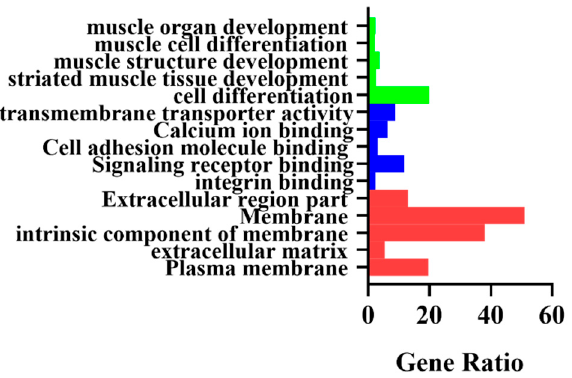
Figure 5. GO enrichment analysis of DEGs. Green bars are biological processes, blue bars are molecular functions, and red bars are cellular components.